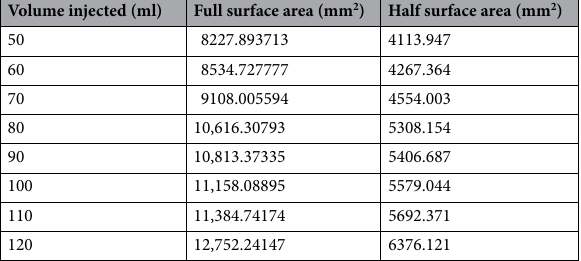
Table 2. Surface area of the different sized expanders. The 50-, 60-, and 70-ml volumes were measured using a 50-ml specification expander. The remaining volumes were measured using a 100-ml specification expander.